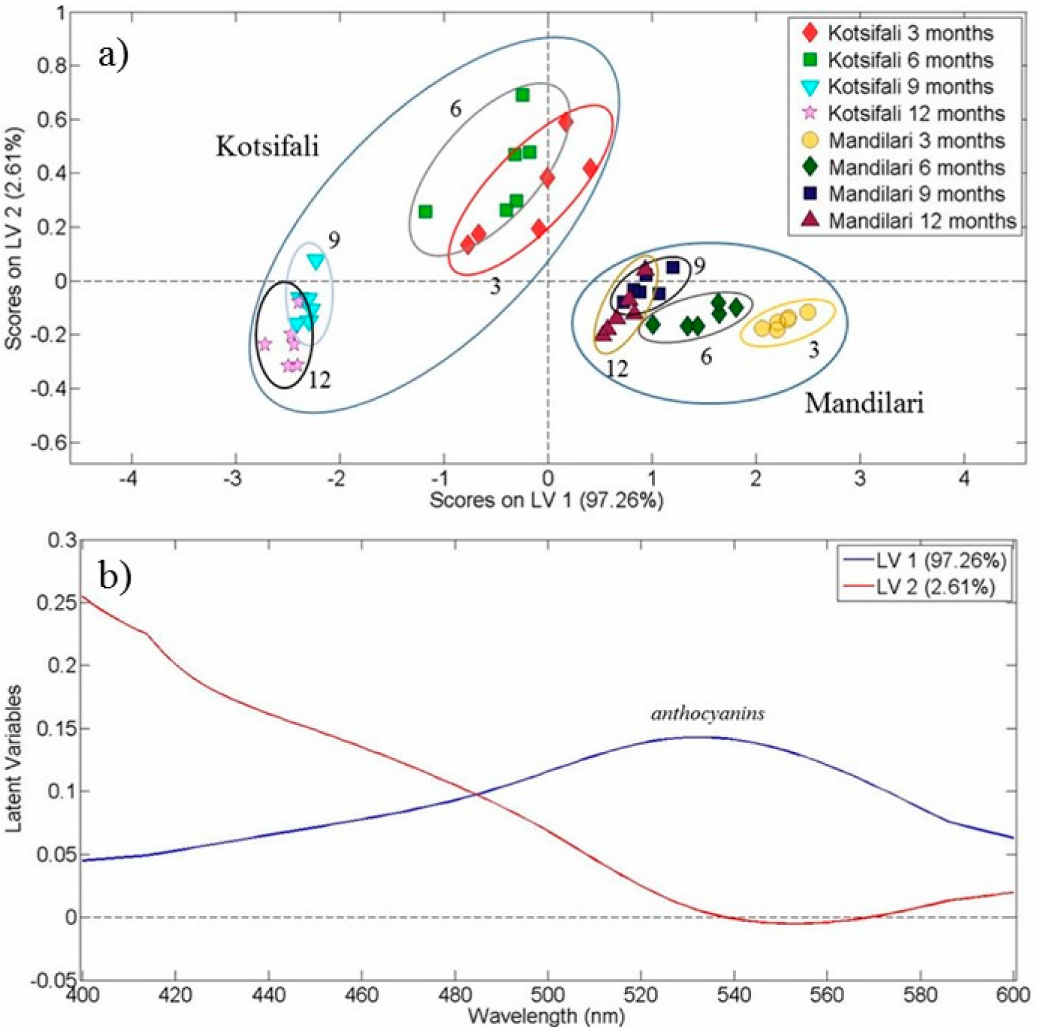
Figure 4. Red wine aging time (3, 6, 9 and 12 months) discrimination. ( a ) Score plot of the first and the second latent variables resulting from the OPLS-DA application on visible spectral data of 48 red wine Kotsifali and Mandilari samples (2013 vintage). The assignment of each category of wine samples is shown in the inset, and ( b ) Corresponding loading plot. Latent variable 1 is designated by the blue line and latent variable 2 by the red